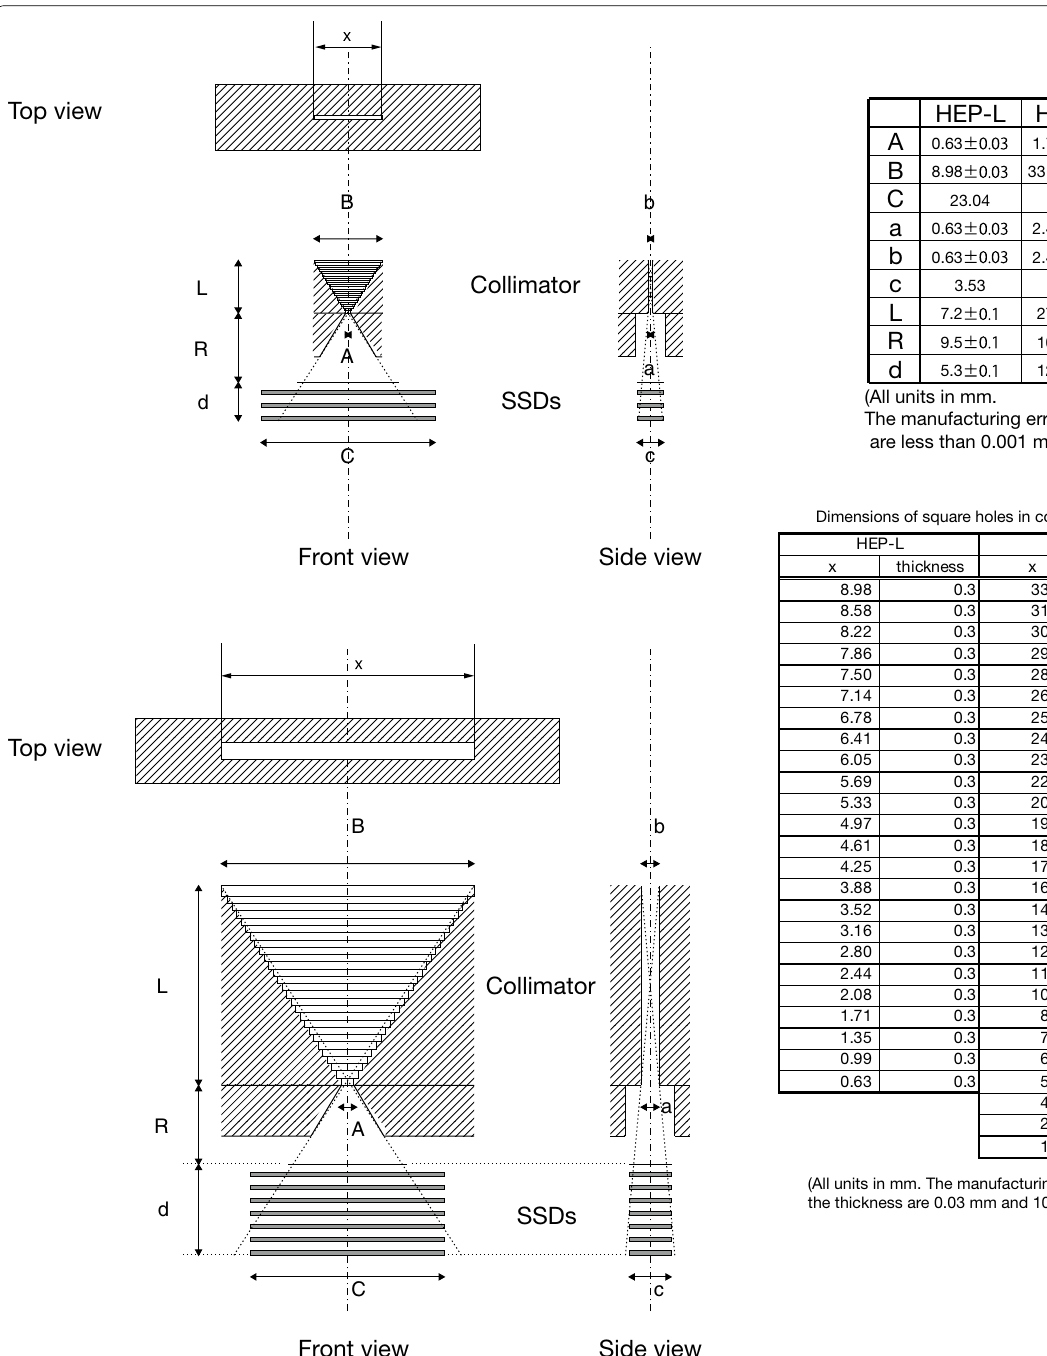
Fig. 3 Collimator geometry and size of detector in one HEP module. Upper figure illustrates collimator and stack of silicon strip detectors (SSDs) (one 50-μm-thick detector and three 600-μm-thick detectors). Lower figure marks dimensions of collimator and detector stack of HEP-H. The silicon stack of HEP-H consists of one 50-μm-thick sheet and seven 600-μm-thick sheets. The values of A, B, C, a, b, c, L, R, and d are listed in the table at the upper right area of the figure. When not otherwise noted, the manufacturing tolerance is 0.1 mm. HEP-L and HEP-H collimators consist of stacked thin Al plates with square holes, and their dimensions are listed in the lower right